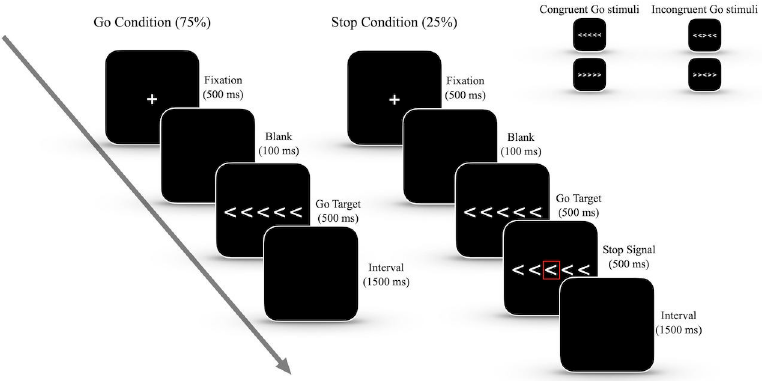
Fig 1. The time-line for a trial of the flanker/stop signal